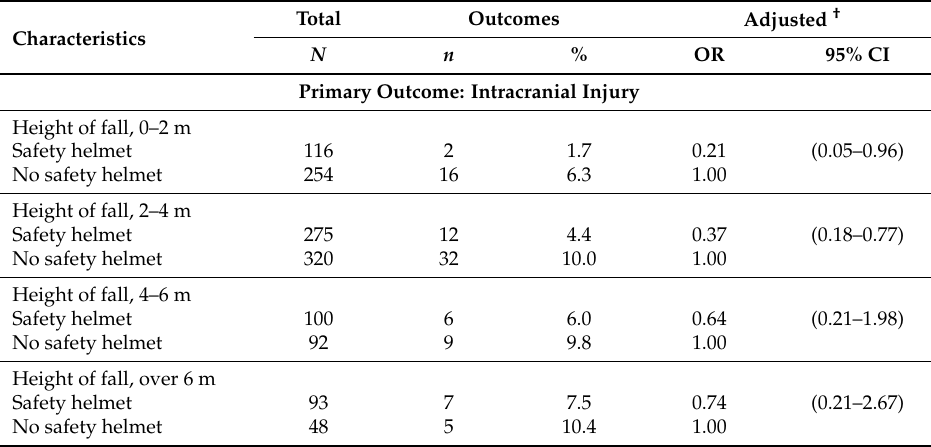
Table 4. Effects of safety helmet in an interaction model with the height of fall injury.